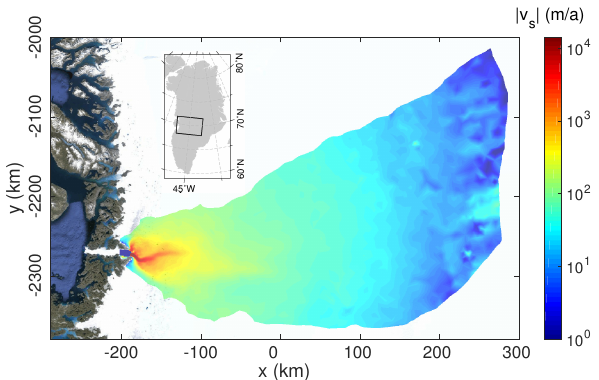
Figure 1. Observed ice surface velocities 2008/2009 (Rignot and Mouginot, 2012) of the Jakobshavn Isbræ drainage basin (logarith- mic scale). Background image from Google Earth © .